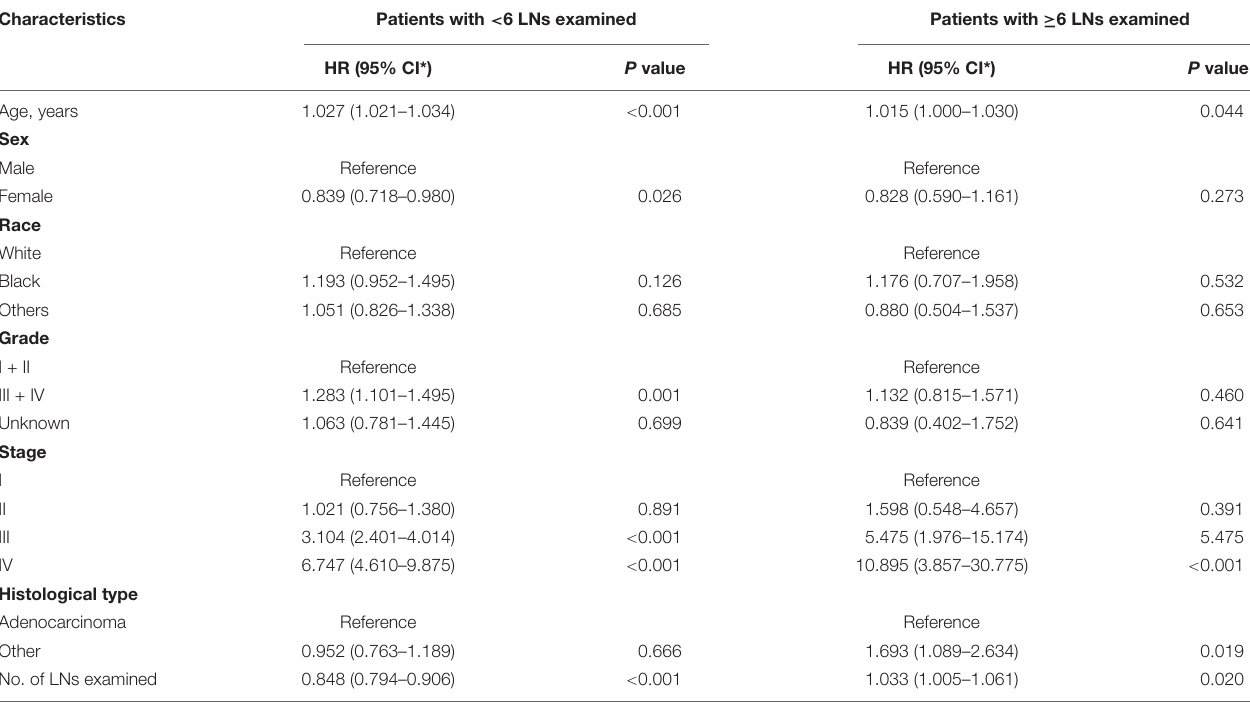
TABLE 2 | Multivariable analysis of OS in patients with GBC.